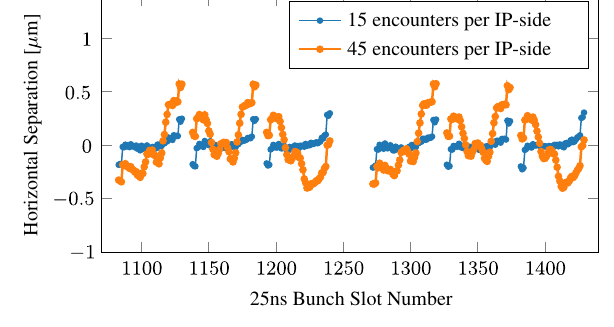
FIG. 16. TRAIN simulation of the closed-orbit separations in LHC fill 5976 (ATS optics, β (cid:2) ¼ 40 cm in ATLAS and CMS, ε ¼ 2 . 5 μ m, N ¼ 1 . 15 × 10 11 ppb). The plot shows the expected separation in horizontal plane of CMS, where the additional long- range beam-beam encounters beyond the 15 in the inner triplets and drift space have the strongest impact.